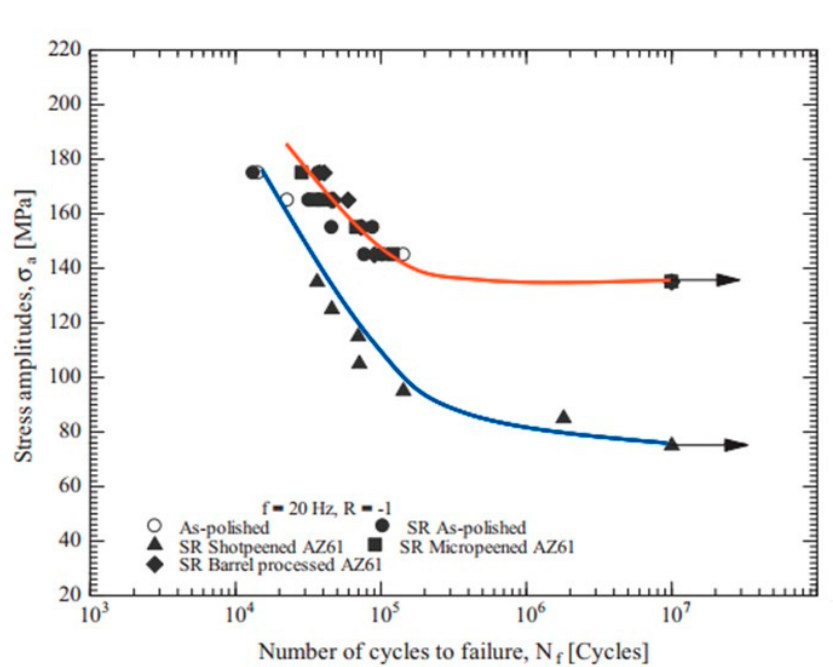
Figure 10. S–N curve of mechanical surface stress relieving treated AZ61 specimen “Reused with permission from Elsevier by License No. 5494631235674”